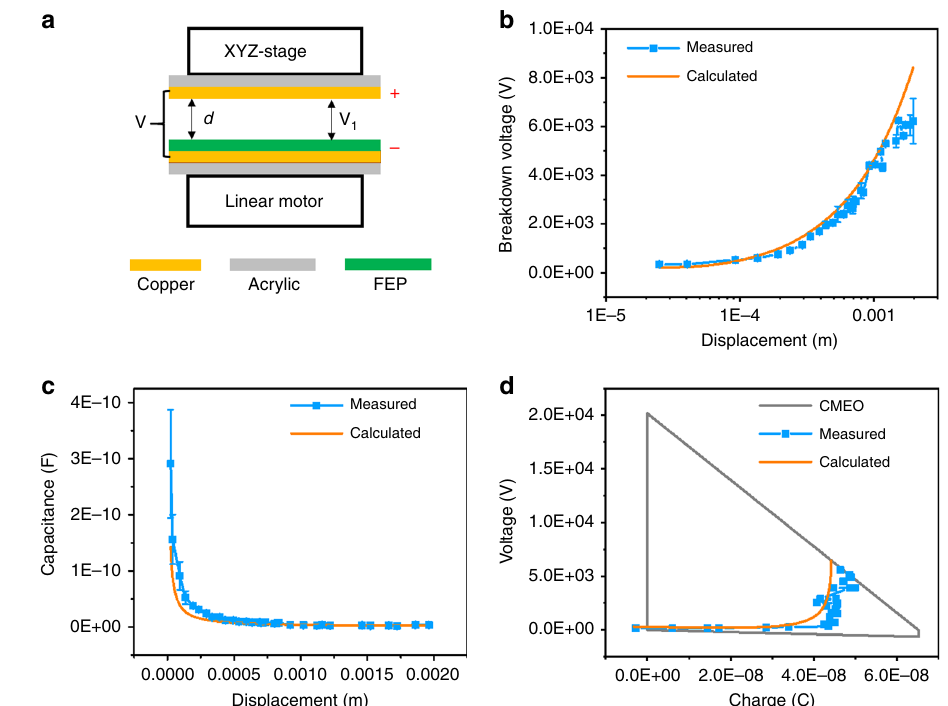
Fig. 3 Breakdown results for a contact-separation triboelectric nanogenerator. a Schematic diagram of CS mode TENG. b Average breakdown voltage V 1 from experiment, compared with theoretical values calculated by Paschen ’ s law. c Average capacitance C , compared with theoretical values calculated by the equation considering two-side edge effects. d Cycle for maximized energy output with the threshold breakdown curve, compared with theoretical curve by Paschen ’ s law. Q SC,max = 67nC. Source data are provided as a Source Data fi le Table. 2 Parameters of the CS mode TENG as the TENG1 Parameters